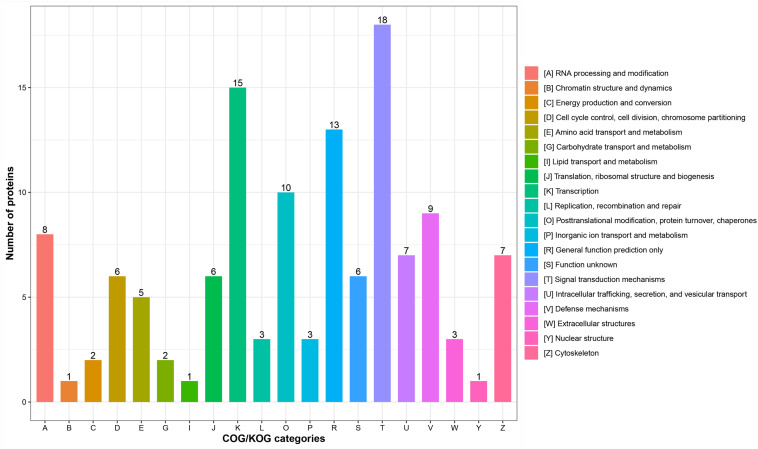
Clusters of Orthologous Groups of protein/EuKaryotic Orthologous Groups (COG/KOG) functional classification analysis of differentially expressed proteins (DEPs). The DEPs were aligned to COG/KOG database and classified into 20 functional clusters. Each bar represents the mummer of DEPs.